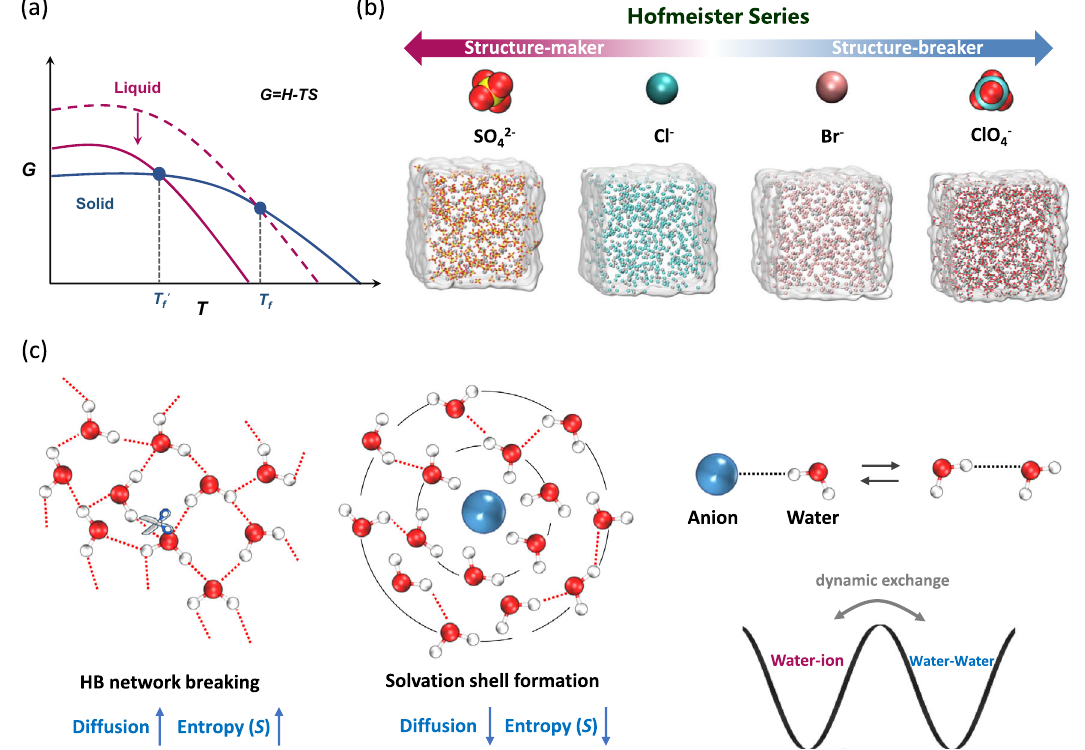
Fig. 1 | Schematic illustrating the design concept for a low- T f electrolyte. a RelationshipbetweenGibbsfreeenergy,entropyofliquidandthefreezingpoint, in which S represents entropy of systems. b Hofmeister series with four different anions (top) and the models of the corresponding four aqueous zinc salt solution for MD simulations (bottom). c The original water molecules form a tetrahedral network structure through hydrogen bonding. When the network composed of